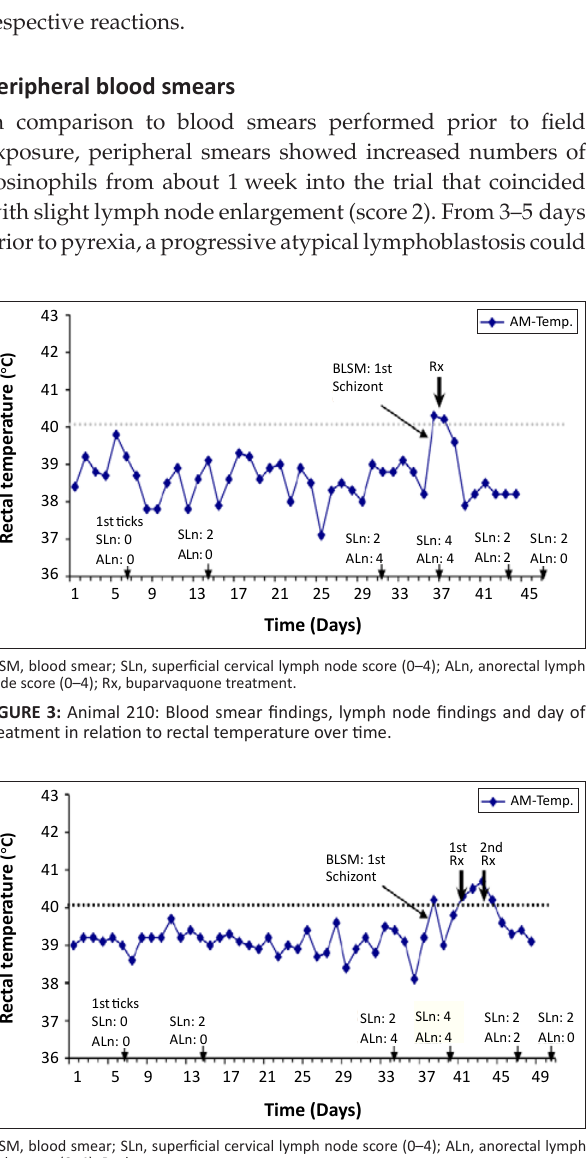
FIGURE 4: Animal 222: Blood smear findings, lymph node findings and day of treatment in relation to rectal temperature over time.